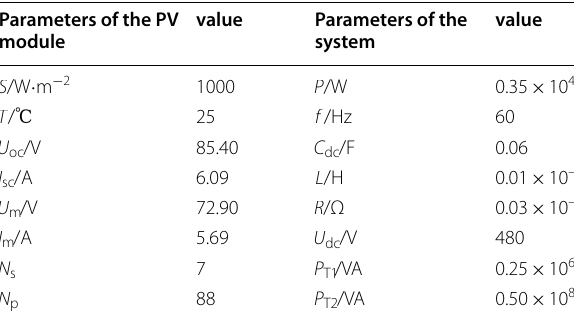
Table 2 Parameters of the simulated